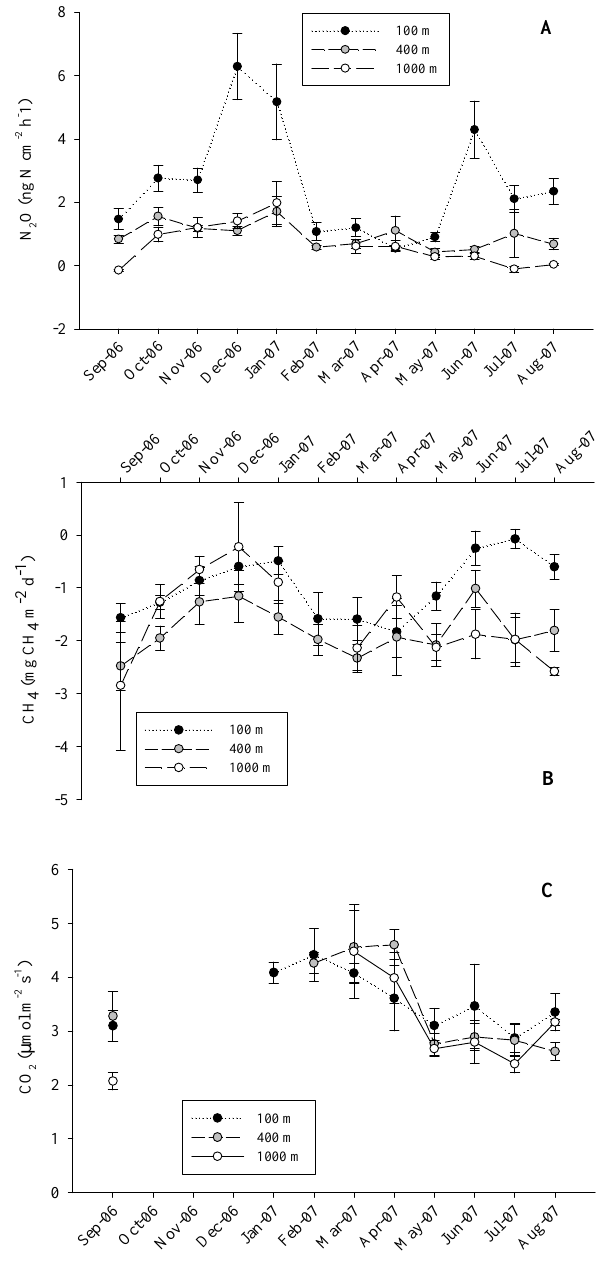
Fig. 3. Monthly soil-atmosphere gas flux of (A) nitrous oxide (N 2 O), (B) methane (CH 4 ) , and (C) carbon dioxide (CO 2 ) at dif- ferent altitudes. Values represent the mean of four replicates per elevation and bars represent standard